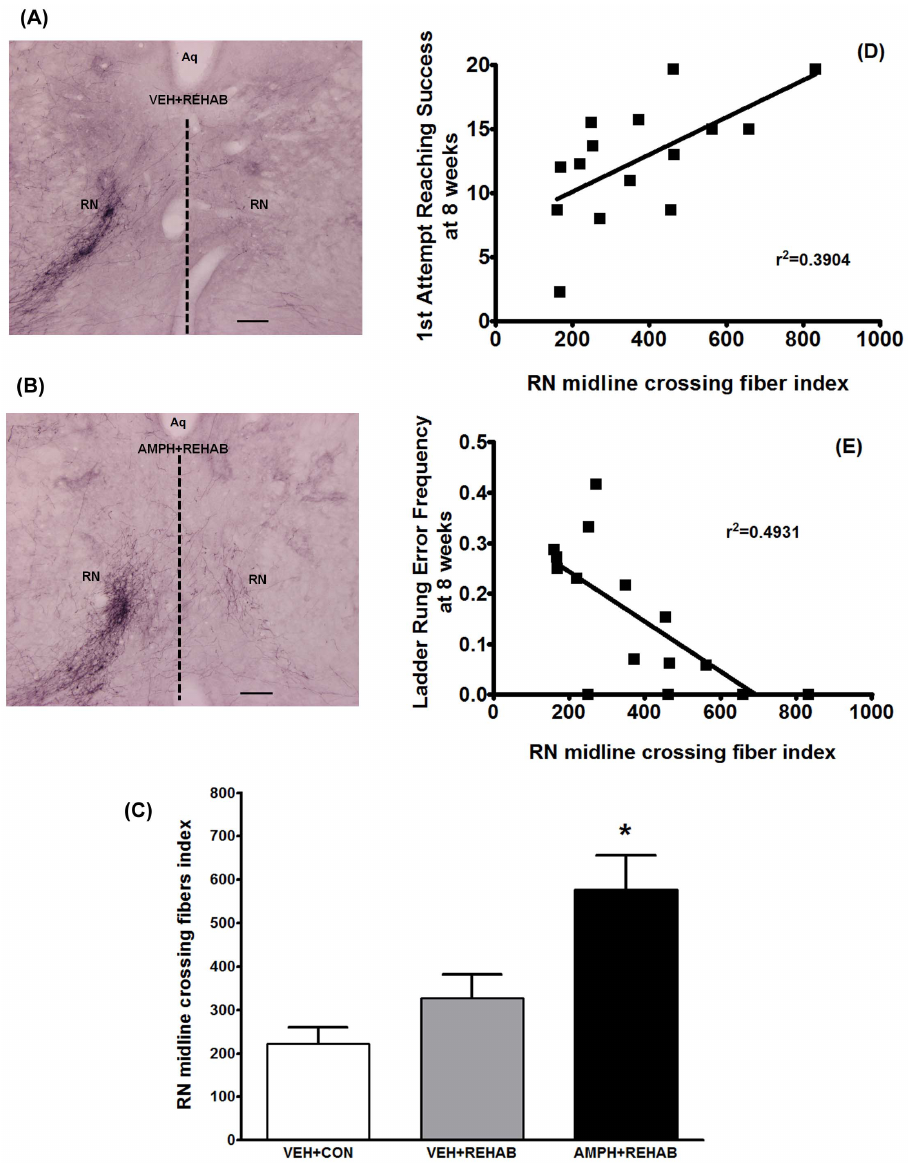
Figure 2. Short term AMPH plus physical rehabilitation enhances axonal outgrowth following stroke. (A) Representative photomicrograph of BDA-positive fiber staining at the level of the red nucleus (RN) in an animal receiving vehicle plus enriched environment with daily sessions of focused activity (VEH + REHAB). Few BDA-positive fibers can be seen crossing the midline (dotted line) from the non-denervated RN (left side) to the denervated side (right). Aq=aqueduct; scale bar represents 100 um. (B) Representative BDA-positive fiber staining at the same level of RN as in (A), but in an animal that received D-amphetamine sulfate (2 mg/kg based on salt weight) plus enriched environment with daily sessions of focused activity (AMPH + REHAB). Note an increase in the number of BDA-positive fibers crossing the midline to the denervated side. Aq=aqueduct; scale bar represents 100 um. (C) Quantification of midline crossing fibers in the area of the red nucleus normalized to the total labeled cerebral peduncle fibers (to correct for differences in the tracing). A one-way ANOVA followed by Student-Newman-Keuls post hoc comparison indicated that midline fiber crossing at the level of the red nucleus was significantly greater following AMPH + REHAB than all other groups (*, p , 0.05). Midline fiber crossing data represent the mean 6 SEM of a subset of 5 animals/group. Panels (D) and (E) depict linear regression and correlation analyses between midline fiber crossing and performance in skilled forelimb reaching (Panel D) and ladder rung walk (Panel E). A significant positive correlation was found between midline fiber crossing and skilled forelimb reaching ( r 2 =0.3904, Pearson’s r =0.6248; p , 0.05). A significant negative correlation was found between midline fiber crossing and footslips (error frequency) in the ladder rung walk ( r 2 =0.4931, Pearson’s r = 2 0.7022; p , 0.005).